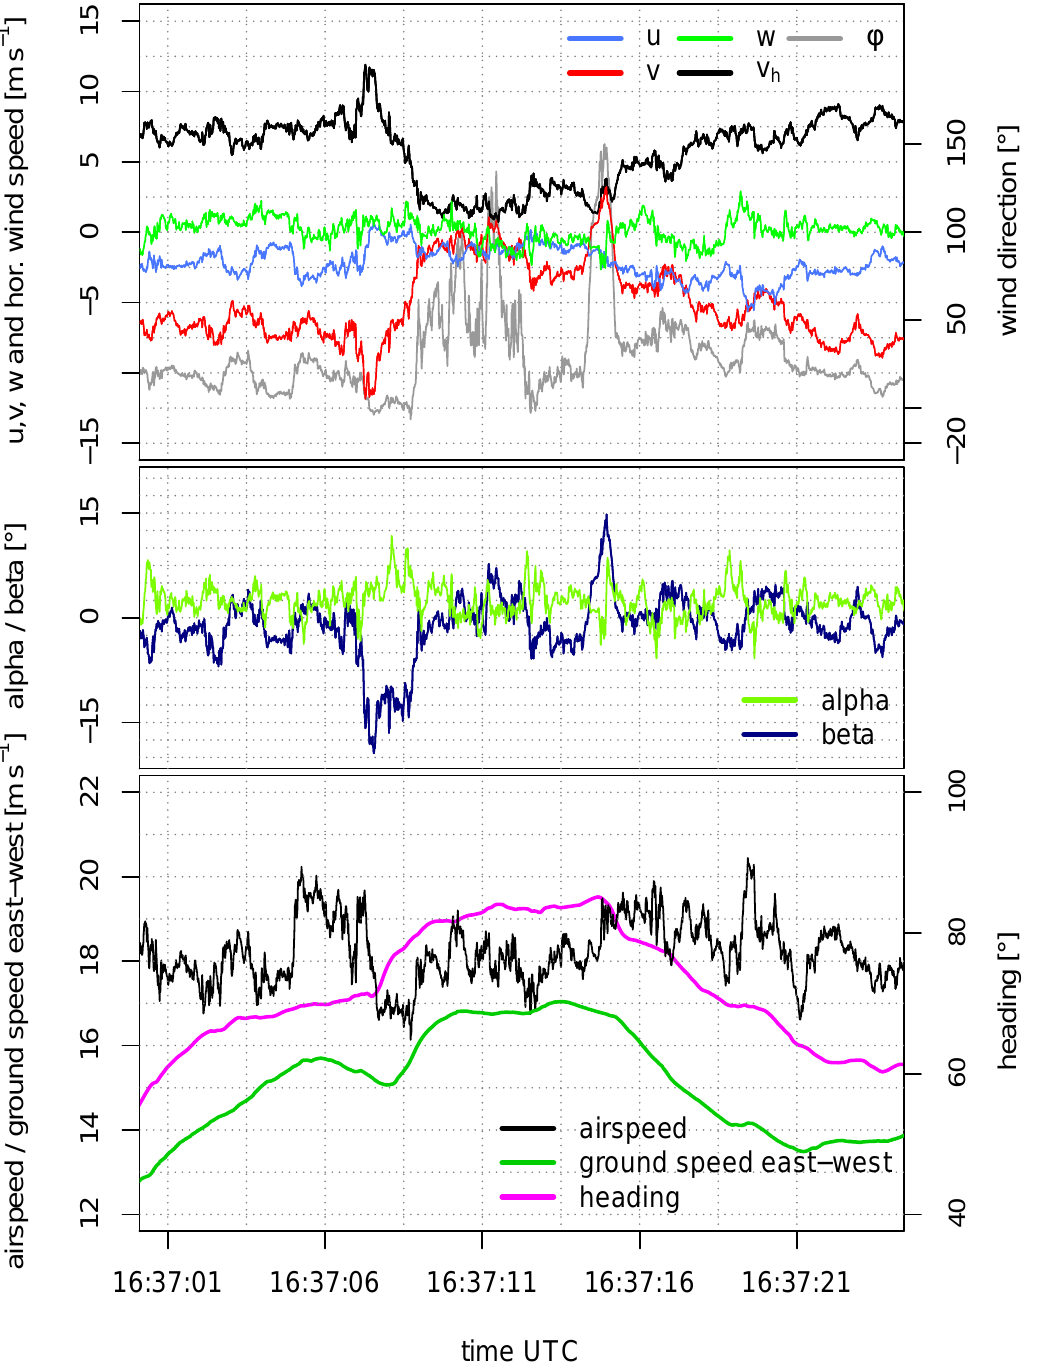
Figure 15. Time series of the wind vector components u , v and w , along with the horizontal windspeed v h and wind direction φ ( top ), the flow angles onto the five-hole probe α and β ( middle ), the true airspeed | (cid:126) u a | , the heading Ψ and the ground speed in east-west direction v g , ew ( bottom